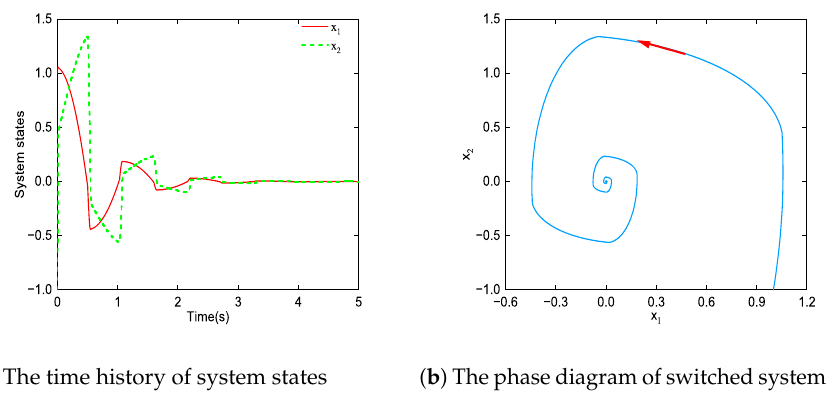
Figure 6. The switched system (12) is asymptotically stable under the switching rule (6). Example 3. The switched system (8) in Example 1 is used to clarify the validity of the switching rule (11)